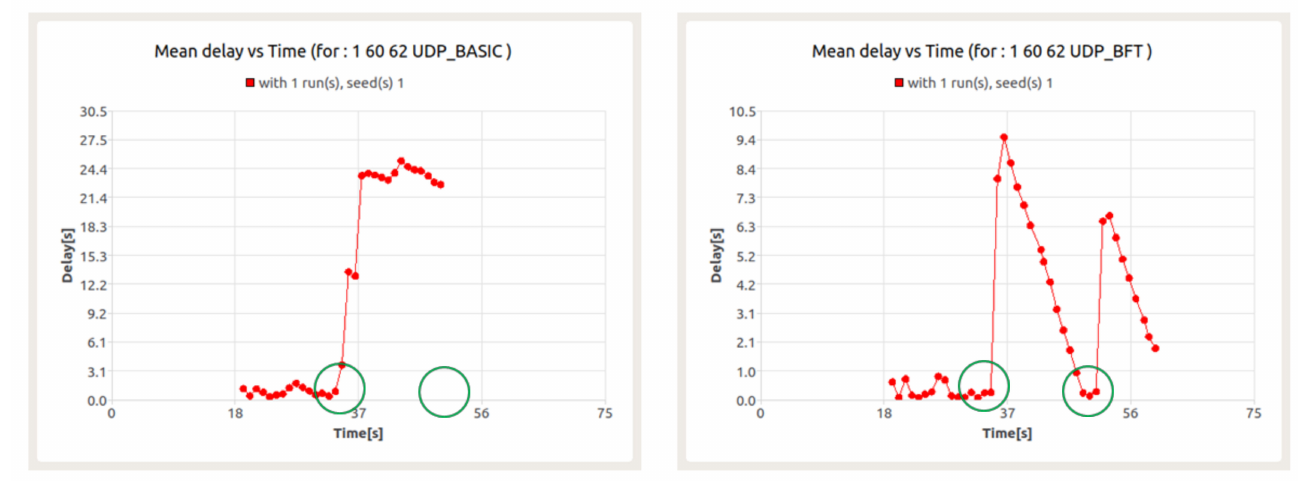
Figure 20. Delay for UDP ( left ) and BFT ( right ) sessions in the presence of background traffic— node 60.